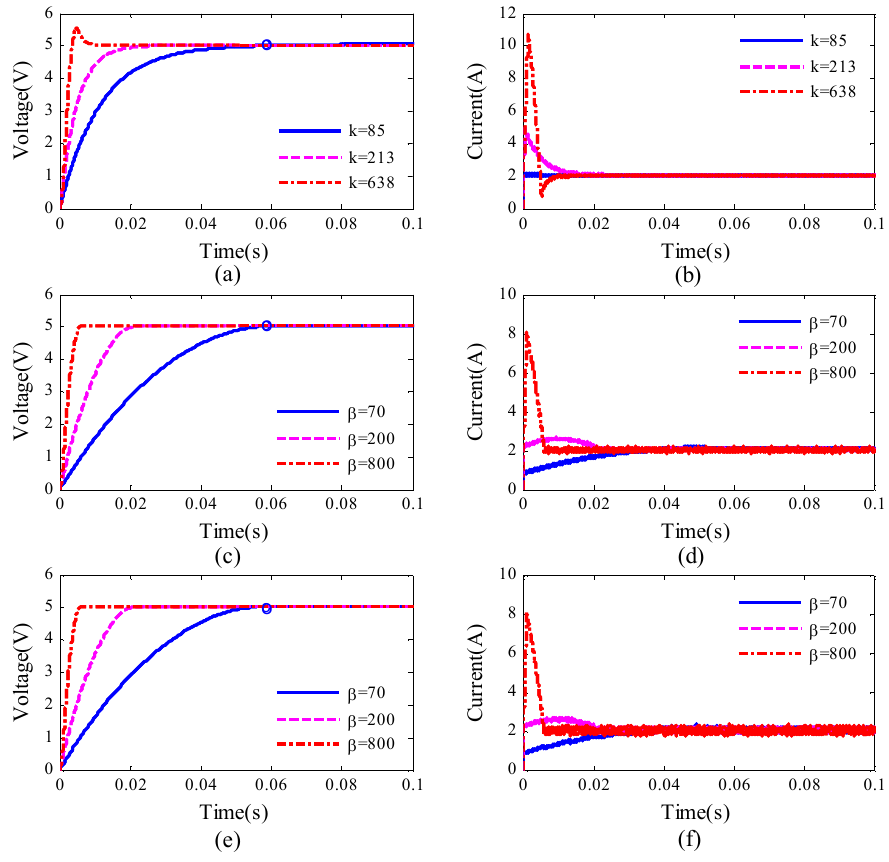
Figure 2. Simulation results of the output voltage and the inductor current curve varies with controller parameters. ( a ) Output voltage of SMC; ( b ) Inductor current of SMC; ( c ) Output voltage of HOSM; ( d ) Inductor current of HOSM; ( e ) Output voltage of HOSM + STD; ( f ) Inductor current of HOSM + STD.